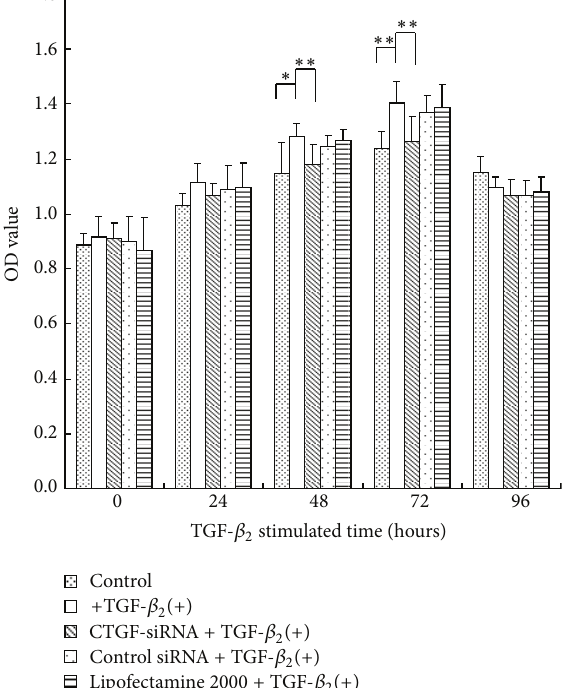
Figure 5: CTGF-siRNA reduces the viability of HTFs. Serum starved HTFs were transfected withCTGF-siRNA, control siRNA, or Lipofectamine 2000 before being stimulated with TGF- 𝛽 2 for 0, 24, 48, 72, and 96 h. The viability of HTFs was analyzed by CCK-8 assay. CTGF-siRNA suppressed the viability of TGF- 𝛽 2 stimulated cells at the time points of 48 h and 72 h, respectively. Data were from three experiments. ∗ 𝑃 < 0.05 , ∗∗ 𝑃 < 0.01 .